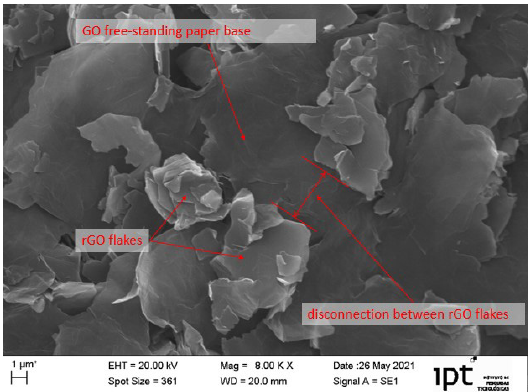
Figure 2. SEM image: the disconnected rGO flakes decorating GO paper at the rGO_52% sample.